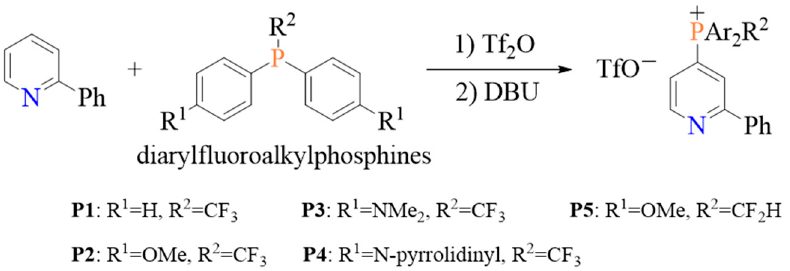
Table 4. Proton affinities of P1–P5 and free energy barriers of the nucleophilic addition reactions of these phosphines to